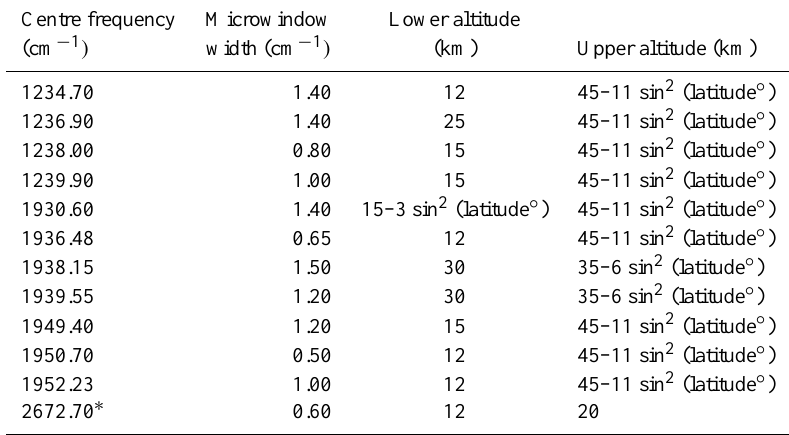
Table 1. Microwindows for the v3.0 ACE-FTS carbonyl fluoride retrieval.